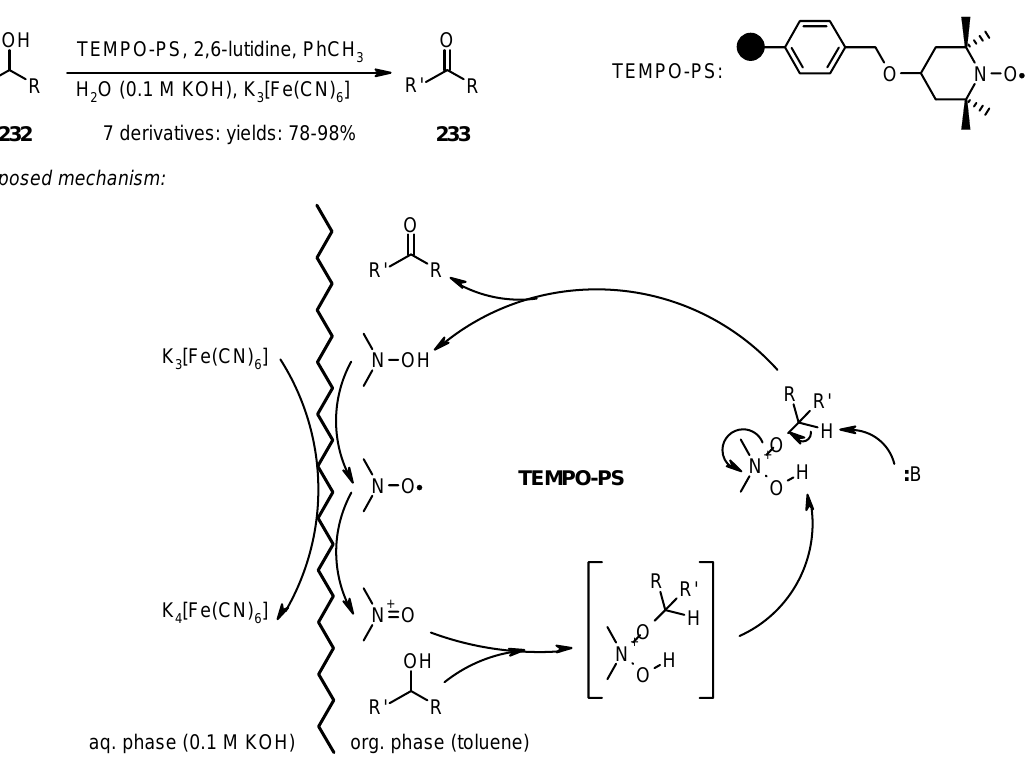
Scheme 74. Kashiwagi’s catalytic two-phase